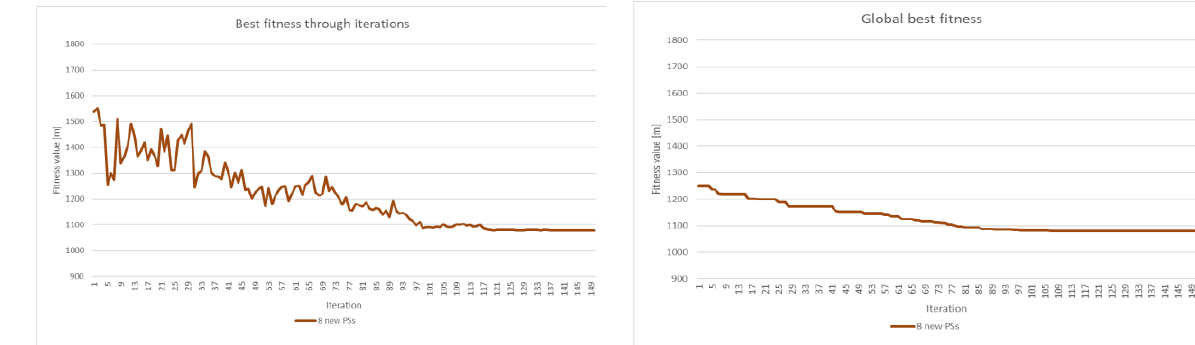
Figure 24. Best fitness through iterations and the global best fitness: eight additional PSs.